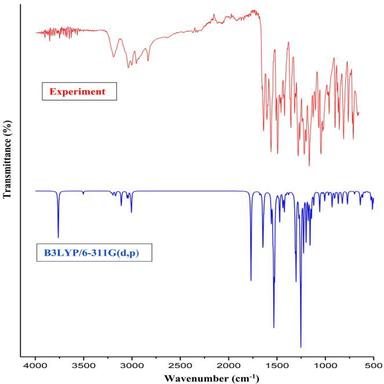
Experimental and theoretical FTIR spectra of (E)-N- -(3-ethoxy-4 hydroxybenzylidene)−4-fluorobenzohydrazide.